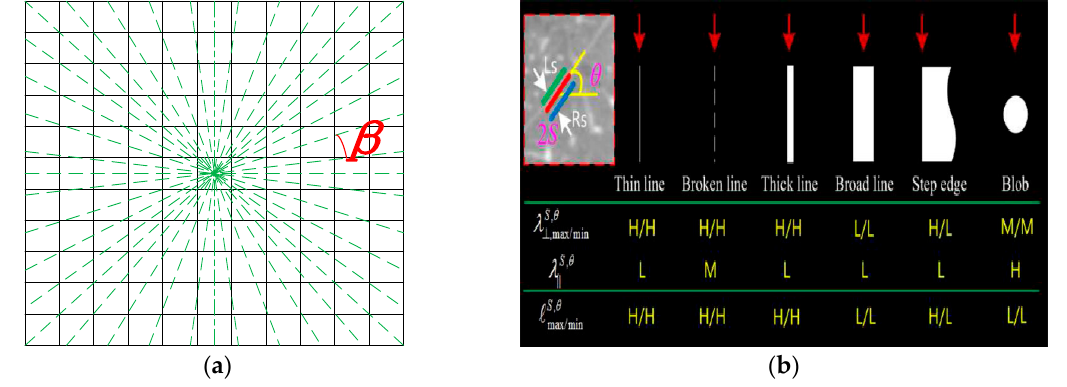
Figure 1. The principle of the derivative of stick (DoS) filter. Here, ( a ) denotes the orientation of the DoS filter, ( b ) depicts the responses of the DoS filter on typical pulmonary structures with the characters H, M and L indicate the high, moderate and low values, respectively. Note this figure is copied from [13] with permission.